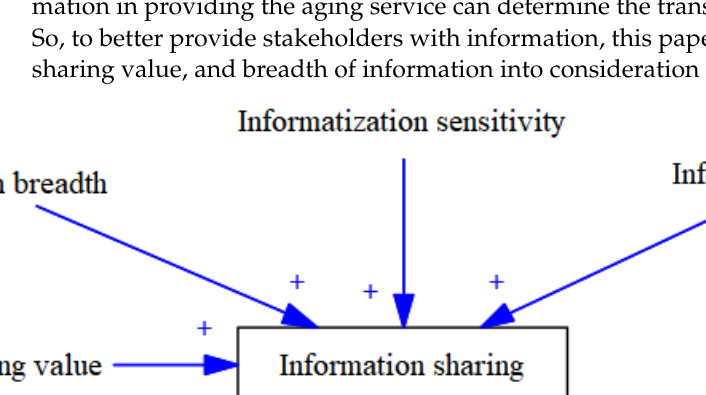
Figure 4. The causal-loop diagram of IS.